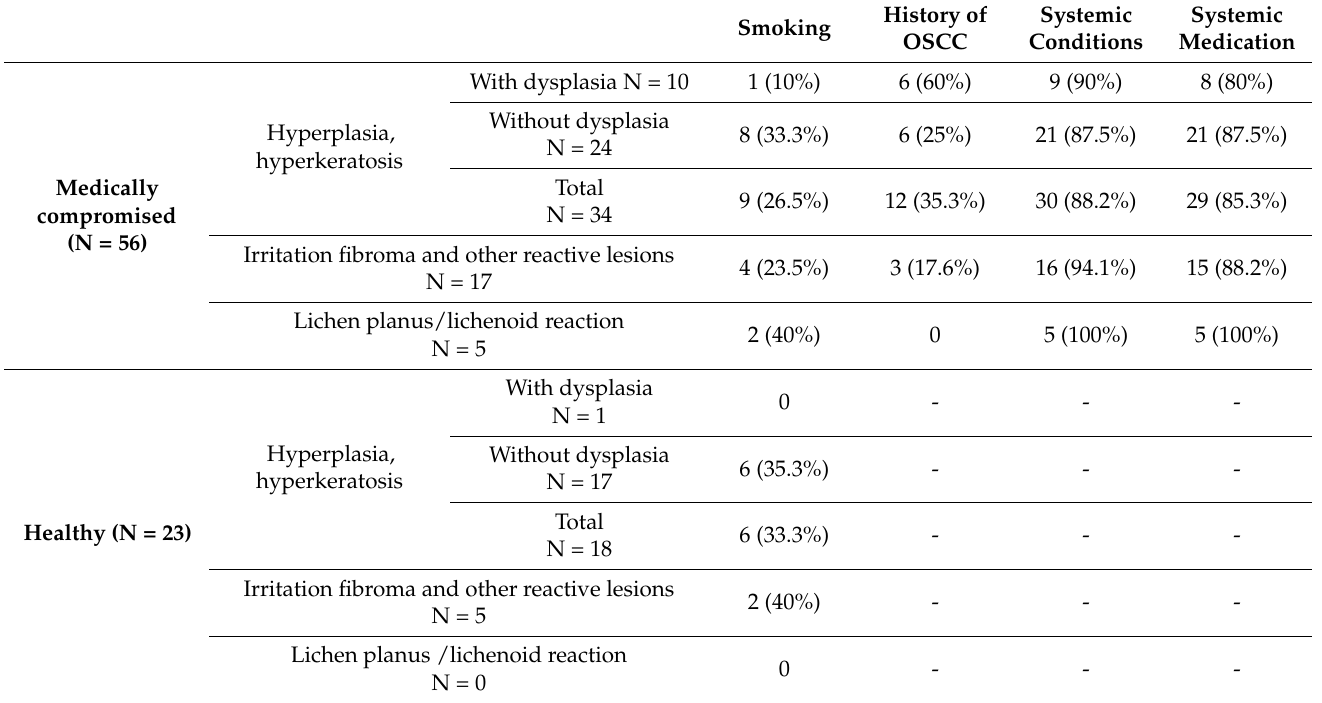
Table 1. Distribution of lesions with candidal hyphae.